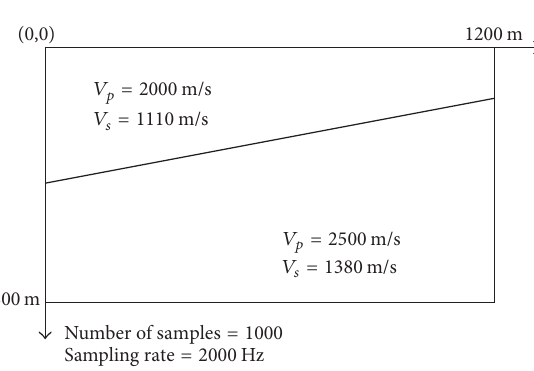
Figure 9: The parameter of the inclined-interface model.